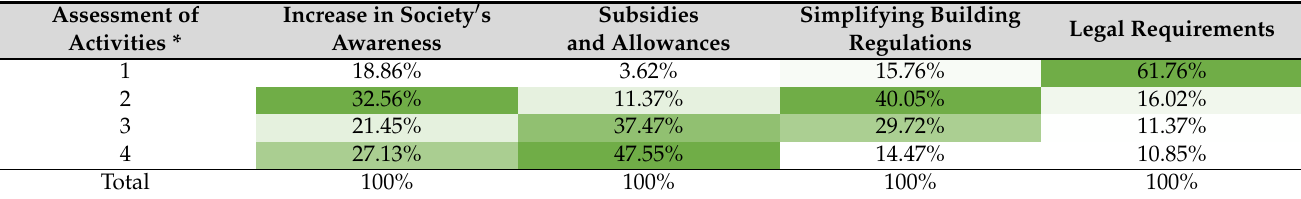
Table 2. Structure of the assessments of activities increasing interest in net-zero energy buildings.